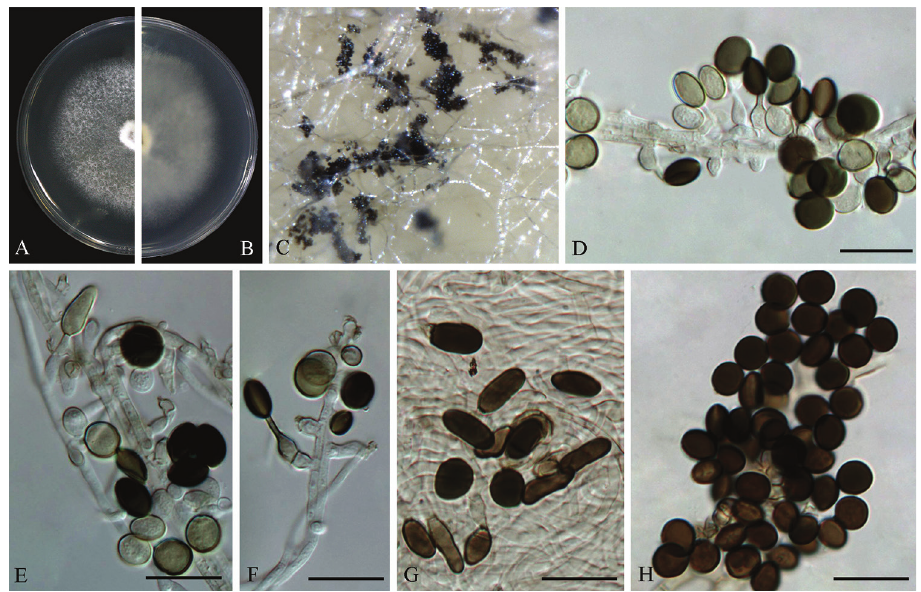
Figure 7. Arthrinium jiangxiense (from ex-holotype strain CGMCC 3.18381) A–B 5 d old cultures on PDA C Colony on MEA producing conidia masses D–F Conidiogenous cells giving rise to conidia G Elongated conidia H Conidia. Scale bars = 10